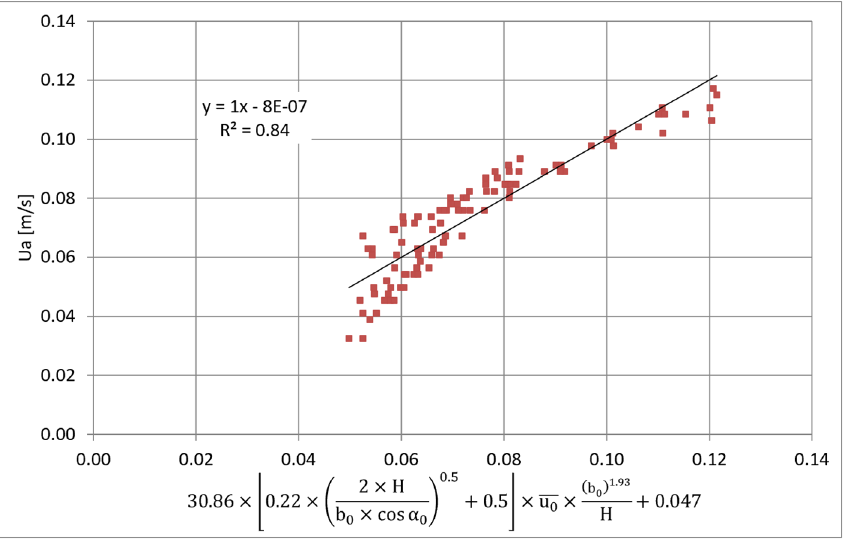
Figure 14. Least square fit for the test results with Re > 3820.